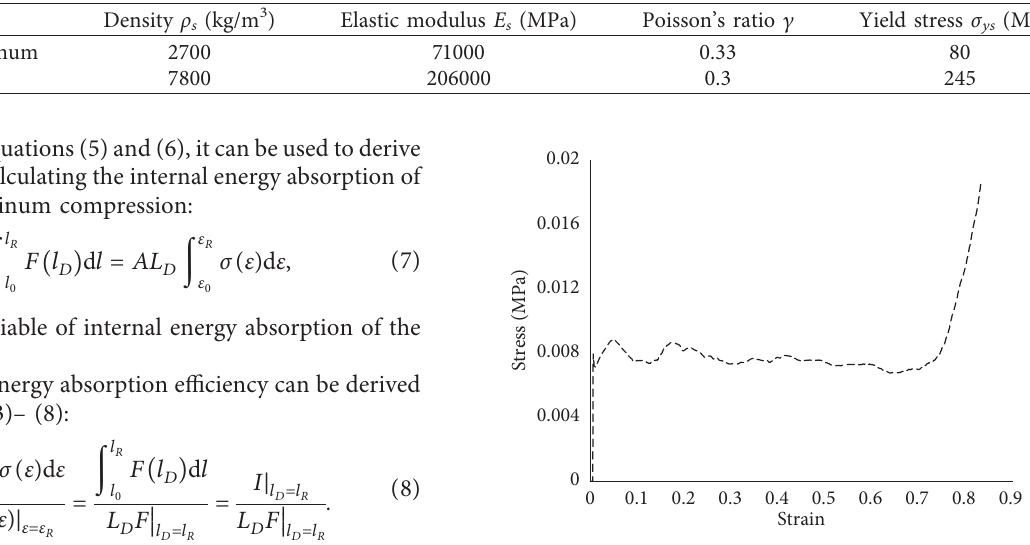
Table 1: Material properties parameters.